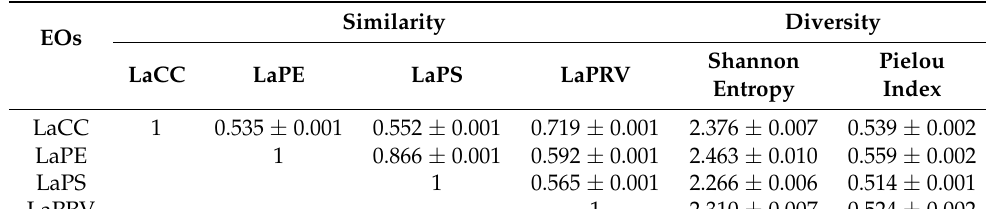
Table 3. Similarity and diversity in the chemical compositions of lavender EOs from four different geographical provenances, assessed with the PMA similarity index (minimum similarity = 0; max similarity = 1) and the Pielou index (minimum diversity = 0; max diversity = 1), respectively. The respective standard errors over the three technical replicates are reported.